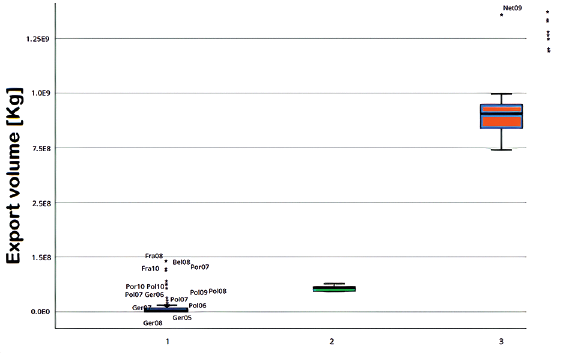
Figure 5. Box diagram of the pre-crisis export variable according to the clusters of the first two-stage clustering level (source: own